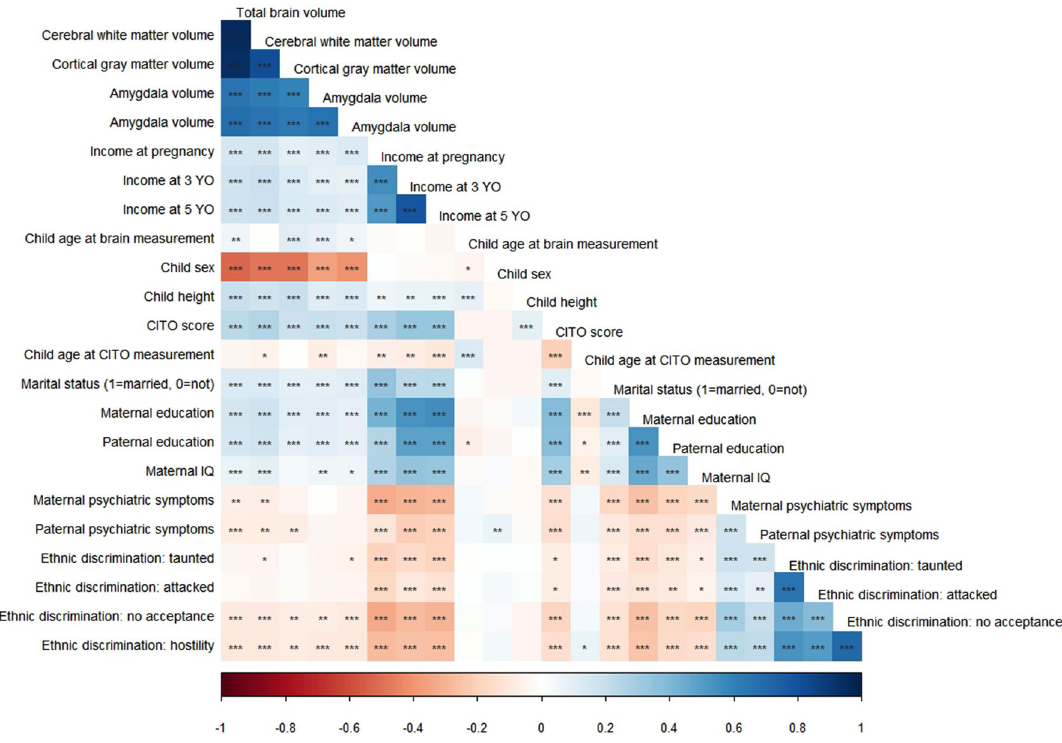
Figure 2. Correlation matrix of child brain morphology, household income, and child and familial demographic characteristics. The color grading gives the correlation strengths. Complete cases were analyzed. * indicates p < 0.05, ** indicates p < 0.01, *** indicates p <